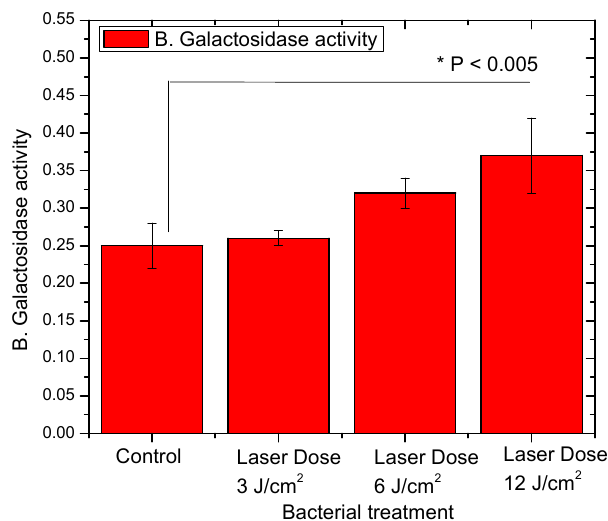
Figure 3. A Histogram showing the change of β -Galactosidase activity (Unit / mL) of L. casei without laser exposure (control) and after exposure to 3, 6 and 12 J/cm 2 laser dosages. * The difference was considered statistically significant ( p < 0.05).